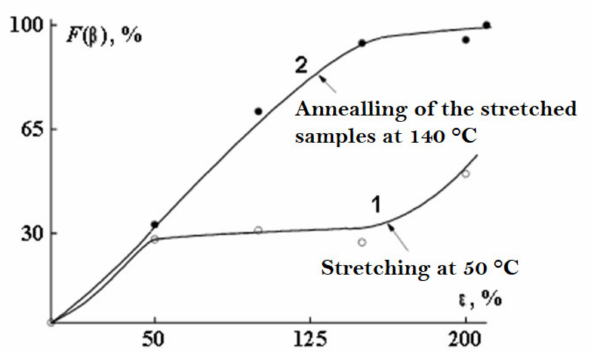
Figure 7. Dependence of the fraction of β -phase crystallites on the degree of stretching for PVDF films stretched at 50 ◦ C (1) and for the same samples after annealing at 140 ◦ C (2)